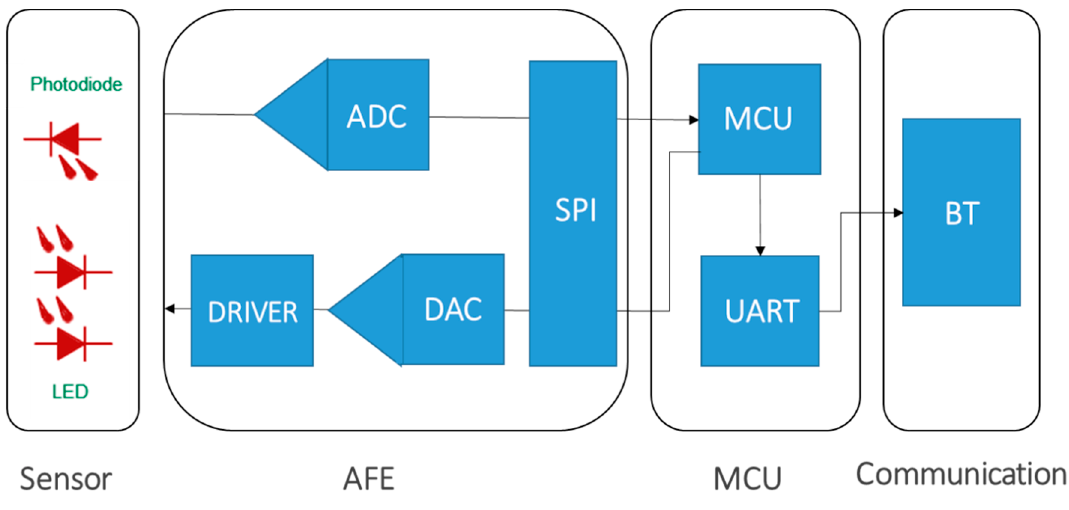
Figure 1. The wearable sensor for 2-channel photoplethysmogram (PPG) sensing. It has an analog front end (AFE) that includes a digital-to-analog converter (DAC) to drive light-emitting devices (LEDs) to emit light to the skin, and an analog-to-digital converter (ADC) to sense the light after skin absorption (transmission mode). It also includes a microcontroller unit (MCU) that communicates with the AFE via a serial peripheral interface (SPI) and with the Bluetooth (BT) module via a universal asynchronous receiver-transmitter (UART).